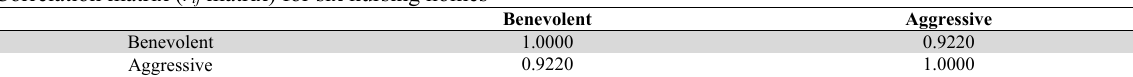
After obtaining the correlation matrix, the weight of the criterion j ( w j ) was obtained using Eq. (7) and Eq. (8). C j was computed using Eq. (8), For example, 2